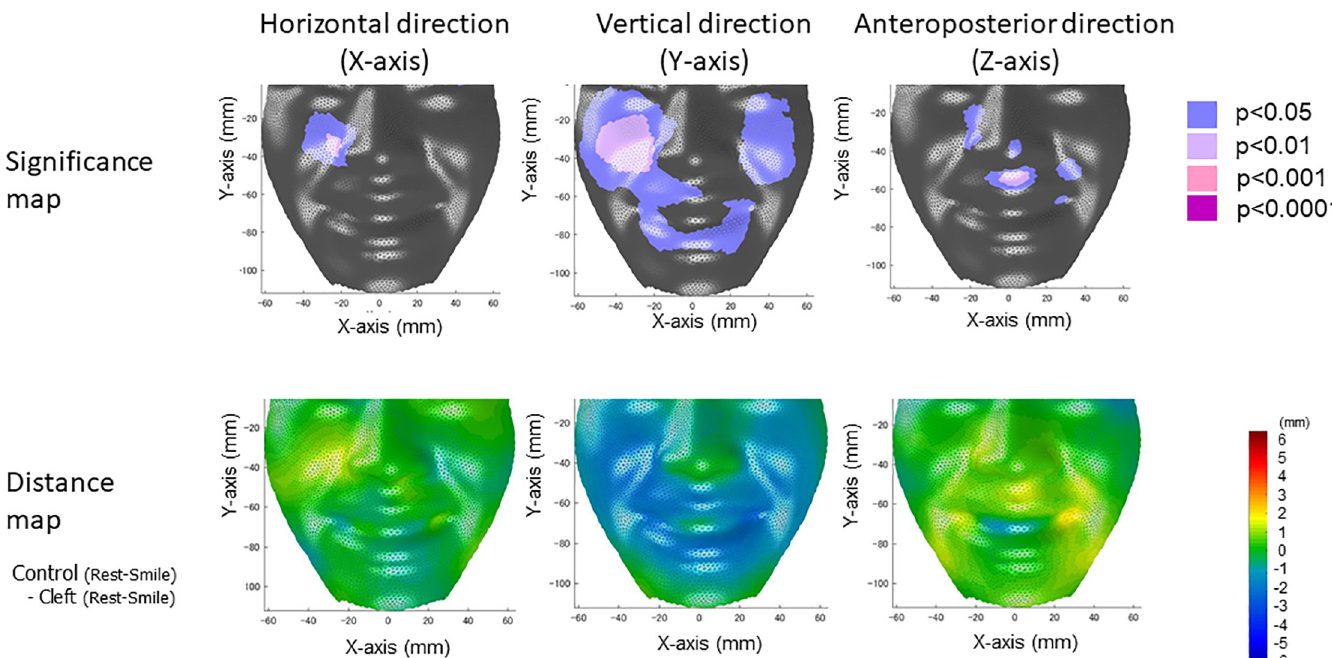
Fig 4. Significance probability maps (top) and distance maps (bottom) of the difference in displacement while smiling between the Control Group and the Cleft group in three directions (horizontal [left], vertical [middle], and anteroposterior directions [right]). For the significance probability maps, blue indicates P < 0.05; pale pink, P < 0.01; dark pink, P < 0.001; purple, P < 0.0001. Adjustment for multiple comparisons was conducted using the Benjamini-Hochberg method. For the distance maps, yellow indicates that the difference in the displacement between the two subject groups (Control group–Cleft group) is a positive value, whereas blue indicates that the difference is a negative value. Displacement was defined as differences in the coordinate values of the face at rest minus those at the peak of the smiling. Thus, in the horizontal direction, on the non-cleft side (right face), yellow indicates a smaller lateral displacement or greater medial movement while smiling in the Cleft group than in the Control group, whereas blue indicates a greater lateral displacement or a smaller medial movement while smiling than in the Control group. On the cleft side (left face), yellow indicates a greater lateral displacement or smaller medial movement while smiling in the Cleft group than in the Control group, whereas blue in the face indicates a smaller lateral displacement or a greater medial movement while smiling than in the Control group. In the vertical direction, blue indicates a greater downward displacement or a smaller upward displacement while smiling in the Cleft group than in the Control group. In the anteroposterior direction in the Cleft group, yellow indicates a smaller retrusive movement or a greater protrusive movement, whereas blue indicates a greater retrusive movement or a smaller protrusive movement than in the Control group.